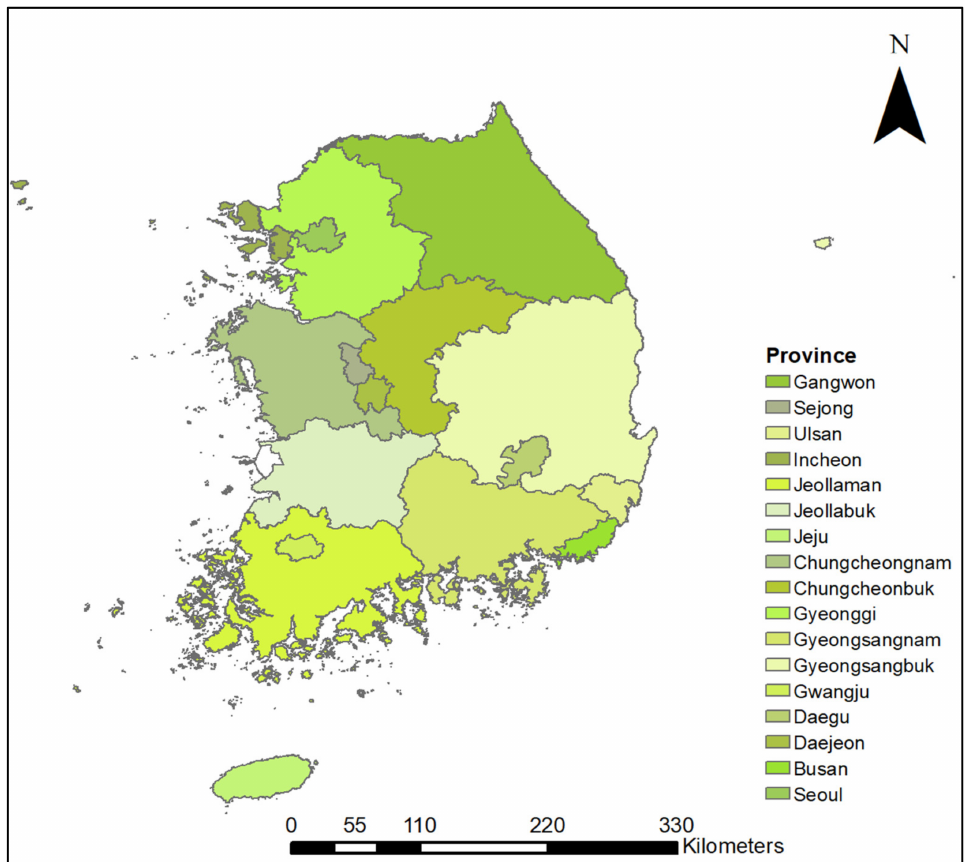
Figure 1. Map of study area. The 17 colors in the map indicate different provinces and mega cities of South